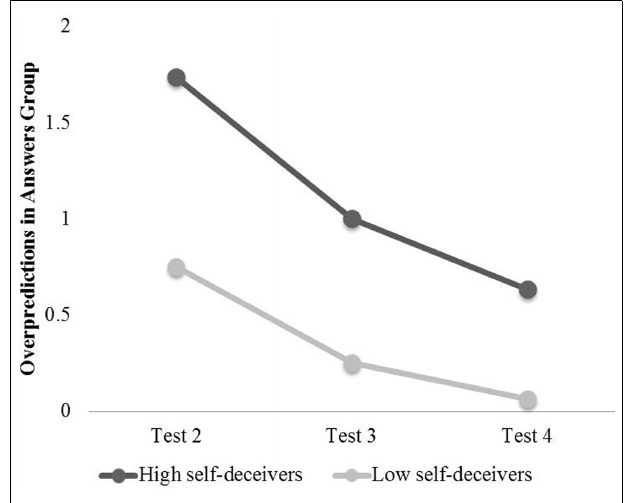
FIGURE 1 | Overpredictions on Tests 2-4 by high and low self-deceivers in Study 1.